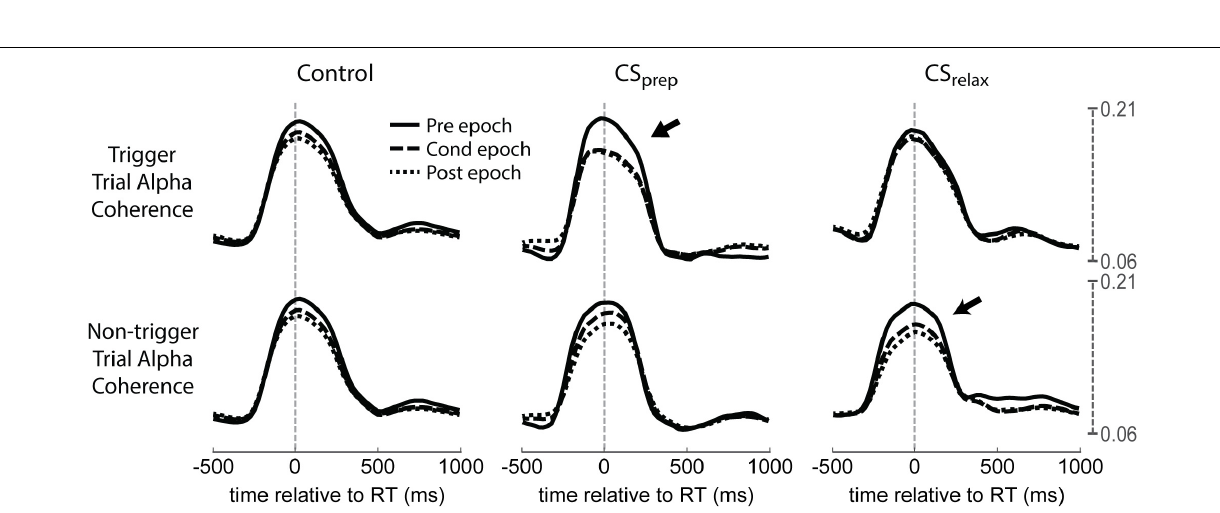
Frontiers in Neuroscience |